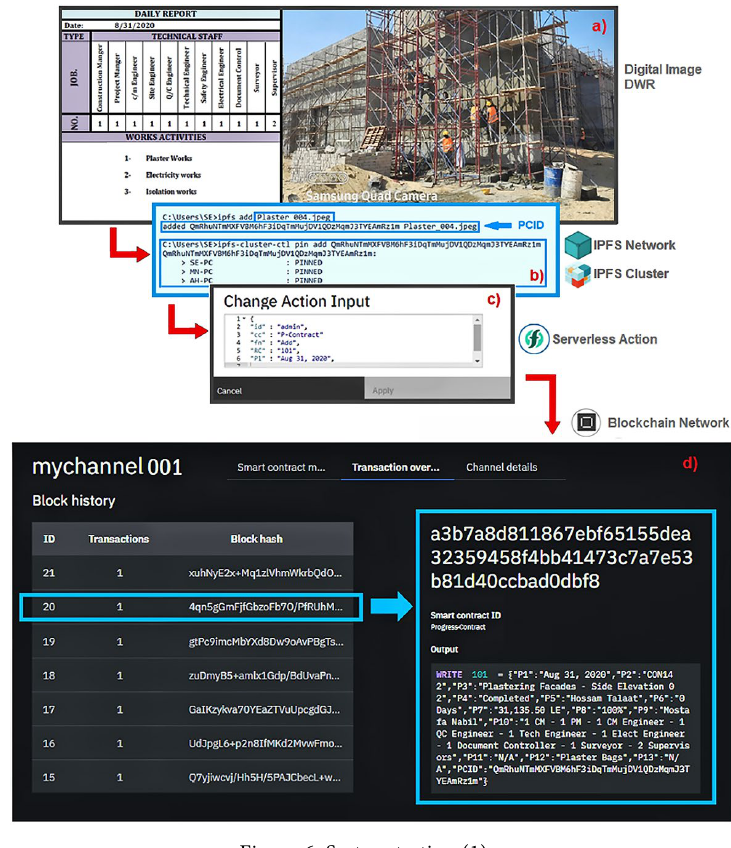
Figure 6. System testing (1)